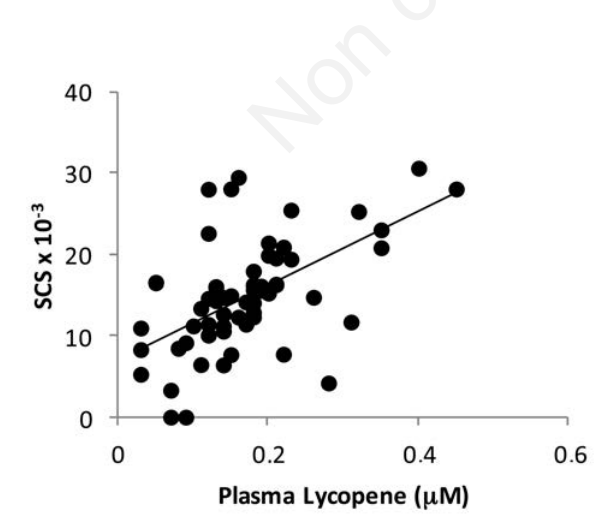
Figure 1. Correlation between plasma lycopene level and skin carotenoid score (SCS) in b -thalassemia patients. The SCS values and plasma lycopene are the mean of two measurements during the year of the study (n=57; r=0.591, P<0.001).